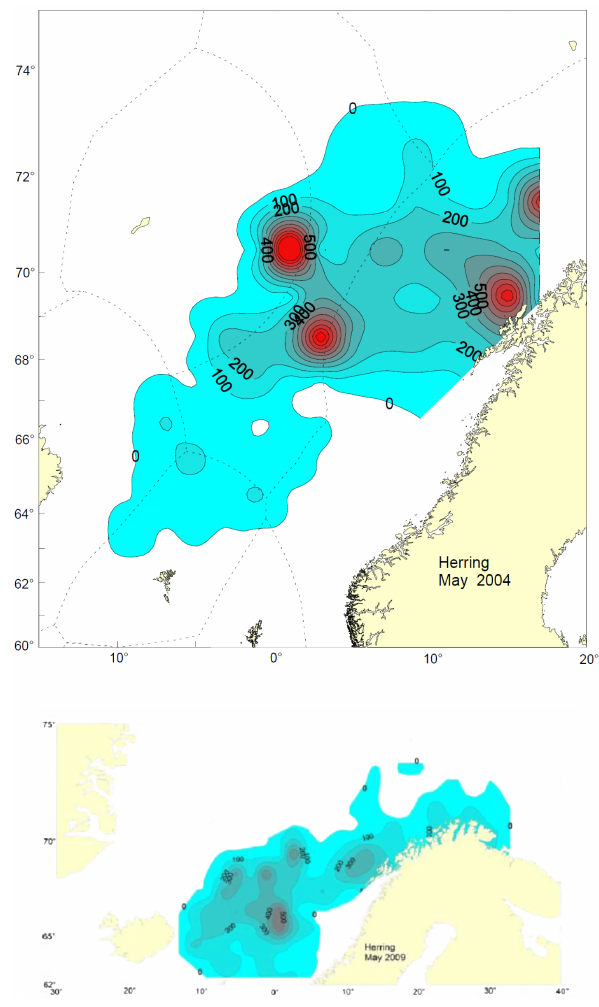
Figure 6. Distribution of NSS herring as measured during the IESNS survey in April–June 2004 (upper) and 2009 (lower) in terms of NASC values based on combined 5nmi values. From ICES (2004) and ICES (2009).